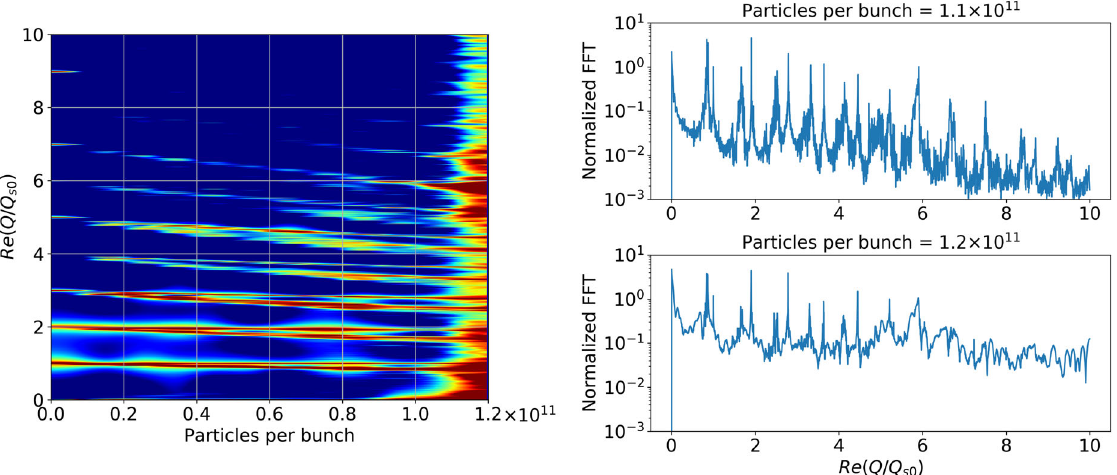
FIG. 7. Left: Real part of normalized mode-frequency shift of the first ten azimuthal coherent oscillation modes obtained with of the results of SBSC with a BBR impedance. In the right-hand side two normalized spectra just below and above the microwave instability threshold are